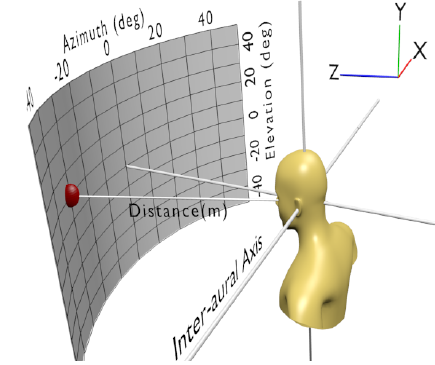
Figure 6: Depth (in meters) Estimation of an audio object. The red sphere represents the sound source whose spatial information is to be extracted.